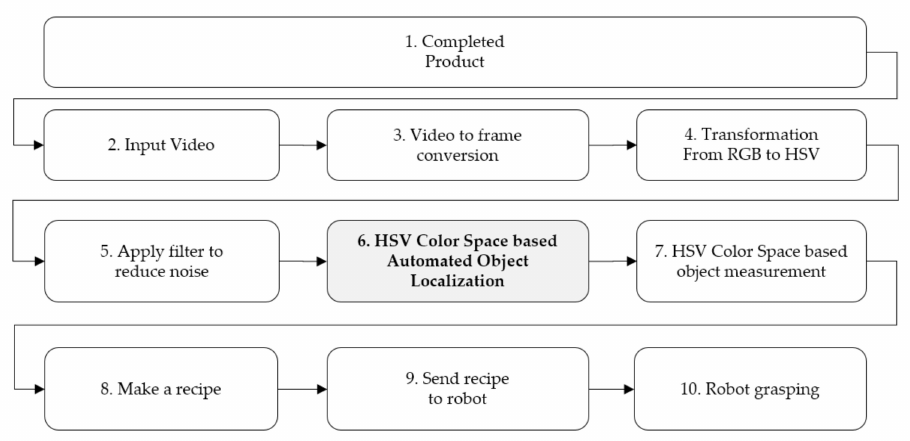
Figure 3. Sequence scenario of automated object feature extraction for robot grasping.